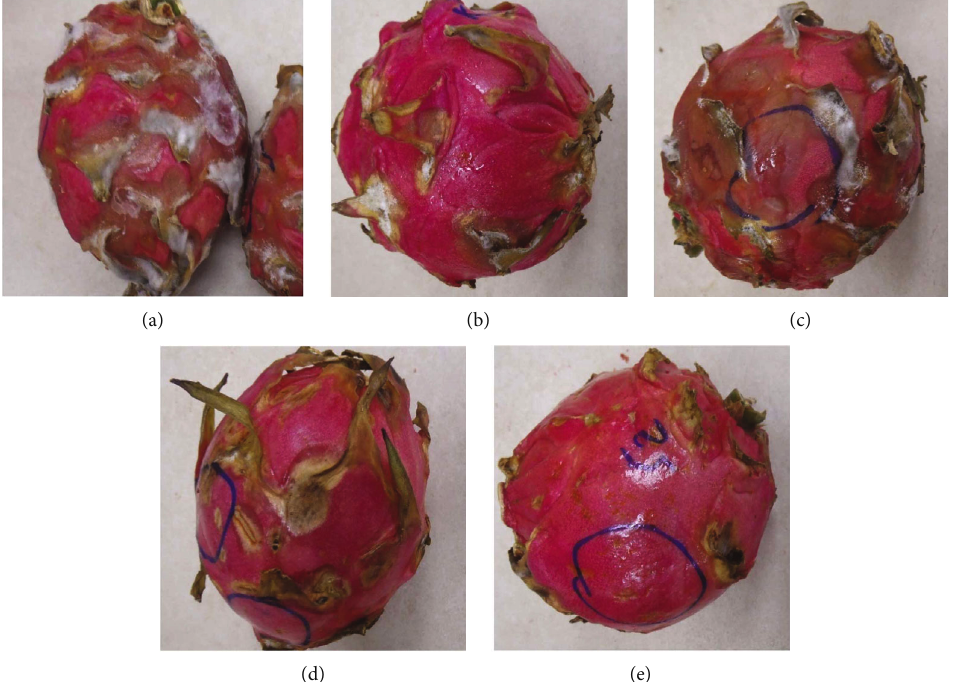
Figure 3: E ff ect of 10% GA incorporated with ginger extract at di ff erent concentrations on disease incidence and severity of dragon fruits after 28 days of cold storage. (a) Control, (b) fungicide (mancozeb-2gL -1 ), (c) 10% GA+5 gL -1 , (d) 10% GA+10 gL -1 , and (e) 10% GA +15gL -1 .